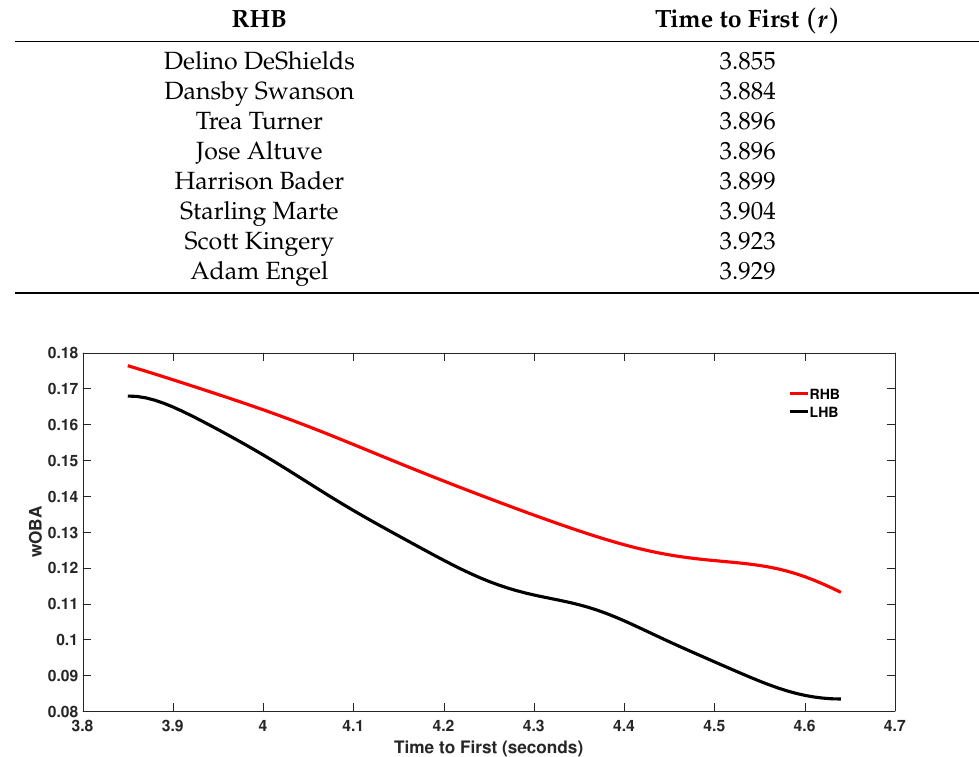
Table 2. Fastest time to first ( r ) for right-handed batters (RHB) in seconds, 2018.